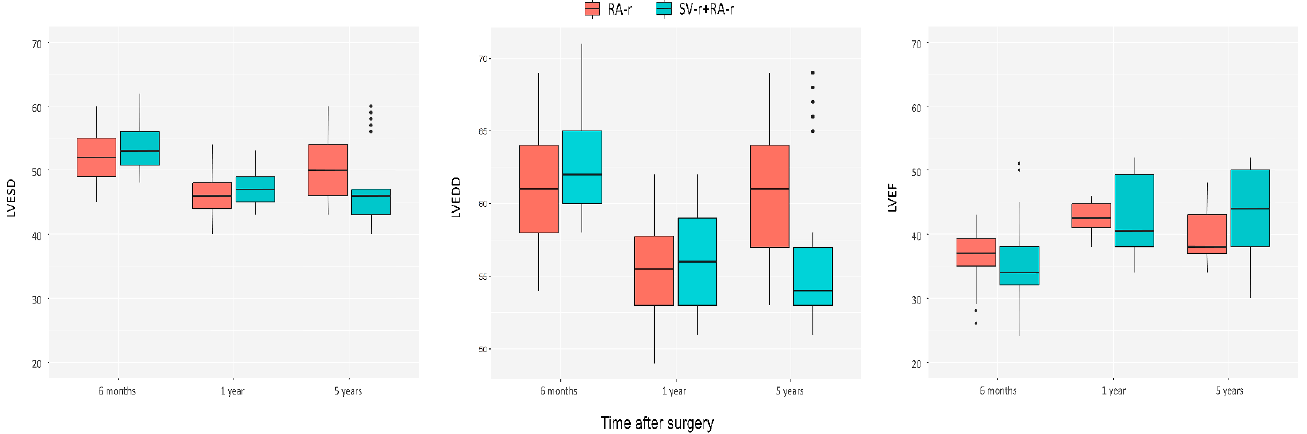
Figure 3. Evolution of the left ventricular end-systolic diameter (LVESD, mm), the left ventricular end-diastolic diameter (LVEDD, mm), and the left ventricular ejection fraction (LVEF, %) after mitral valve repair in the group who underwent subvalvular repair combined with restrictive annuloplasty repair (SV-r + RA-r group) and in the group who underwent restrictive annuloplasty repair (RA-r group). Table 2. LV remodeling and MR at follow-up after SV-r + RA-r and RA-r.